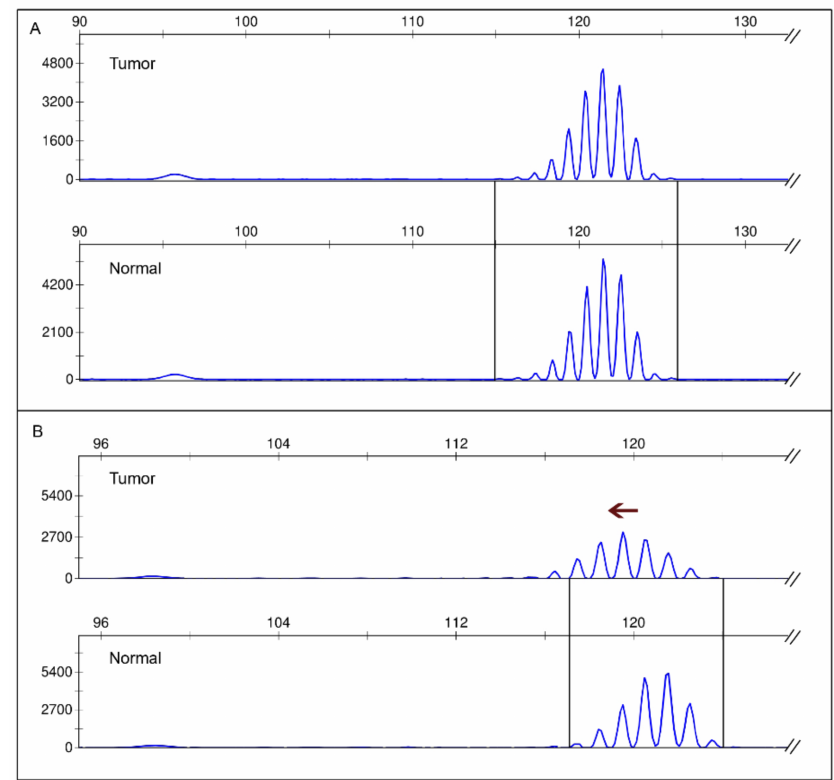
Figure 1. Doubtful microsatellite instability (MSI) profile of endometrial cancer (EC) after PCR and fragment length analysis using the Bethesda panel exemplarily shown for marker BAT25. ( A ) Stable BAT25 marker of the microsatellite stable (MSS) EC sample 11 (cohort 1) with its paired normal control. ( B ) Small left shift of the unstable BAT25 marker of the EC sample 1 (cohort 1) with its paired normal control. Arrow points to the small left shift indicating the marker as microsatellite instability-high